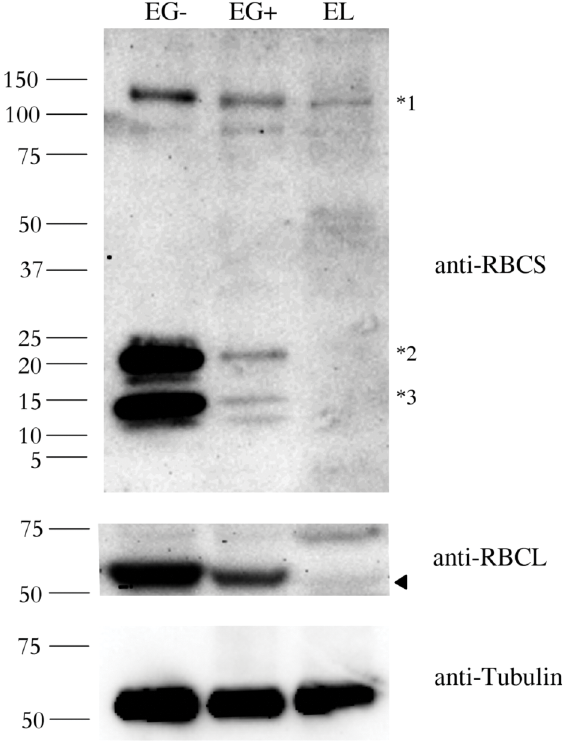
Fig 2. Abundance of the RBCS and RBCL proteins in Euglena gracilis and Euglena longa . Protein immunodetection was performed using anti-RBCS, anti-RBCL, and anti-Tubulin antibodies. Three bands with different molecular weights were observed in anti-RBCS immunoblotting. The ~130 kDa band (marked * 1) corresponds to polyprotein synthesized in the nucleus. The ~15 kDa band (marked * 3) corresponds to the processed monomer after cleavage of the signal sequence and excision of decapeptides. The ~22 kDa band (marked * 2) possibly corresponds to a monomer still attached to the transit peptide. The identity of the RBCL protein (arrowhead in the anti-RBCL panel) was confirmed by mass-spectrometry. Tubulin served as a loading control. Molecular weights in kDa are indicated on the left. EG-, E . gracilis cultivated photosynthetically (without ethanol); EG+, E . gracilis cultivated mixotrophically (with ethanol); EL, E . longa